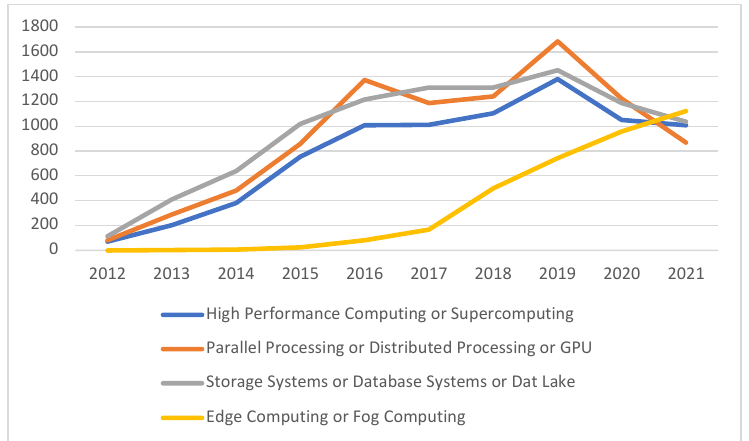
Figure 5. The number of research publications per year for the Big Data-enabling technologies of high-performance computing or supercomputing; parallel processing, distributed processing or GPU; storage systems, database systems or data lakes and edge computing or fog